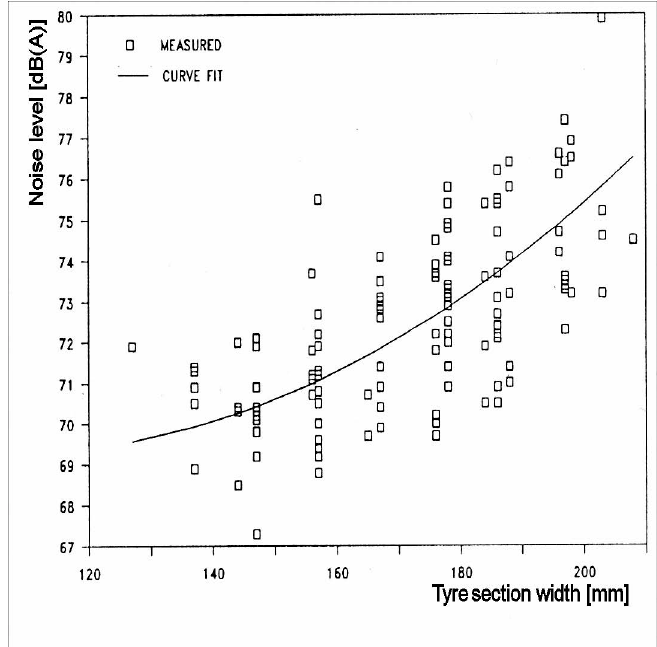
Figure 8. Relation between TPIN level and tire width (data based on measurements 1981–1987 on radial car tires in Germany, Sweden and Norway) (source from Storeheier and Sandberg, 1990 [95]; reprinted with permission from Dr. Ulf Sandberg of VTI, Sweden. Dr. Sandberg also informed that the